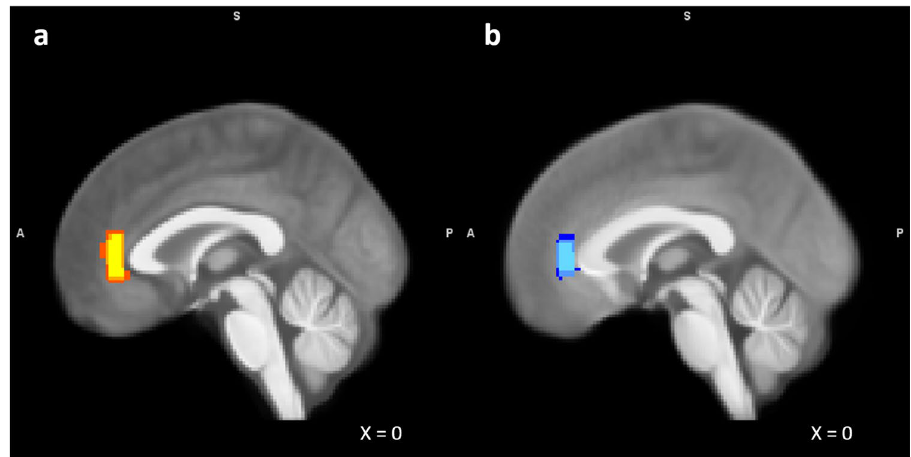
Figure 4. Overlap of individual MRS voxel placements in cohort 1 ( a ) and cohort 2 ( b ) overlaid on the mean T1-weighted image of participants in each respective cohort. A: 3 T sample (n = 27). Red = 25% overlap. Orange = 50% overlap. Yellow = 75% overlap. B: 7 T sample (n = 98). Dark blue = 25% overlap. Blue = 50% overlap. Light blue = 75%